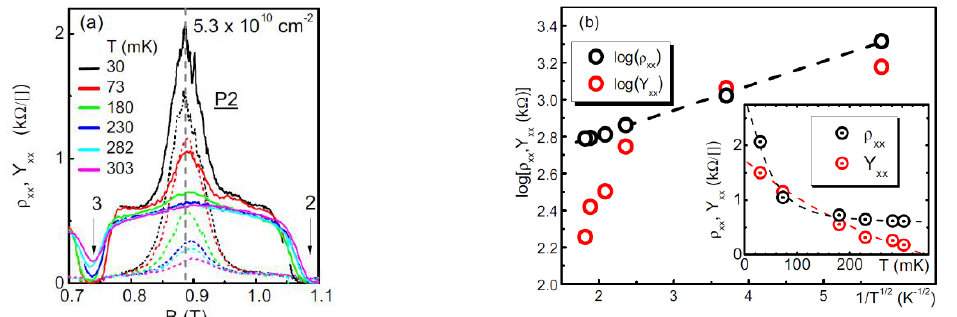
Figure 3. ( a ) 2D MIT at a zero magnetic field in a dilute 2D hole system in a 10 nm wide GaAs quantum well, 𝑝 𝑐 ~ 0.8 × 10 10 cm 2 ⁄ . ( b ) 𝜌 𝑥𝑥 (𝐵) with 𝑝 = 0.86 × 10 10 cm 2 ⁄ . ( c ) Arrhenius plot of the RIP peak resistance at various hole densities. ( d ) The fitted thermal activation gap. Figure from Reference [10].